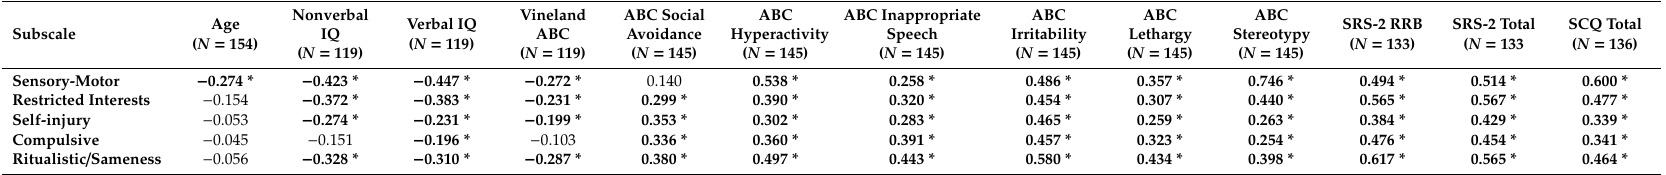
Table 2. Correlations between the RBS-R subscales according to Bishop et al.’s (2013) five-factor structure and clinical measures.